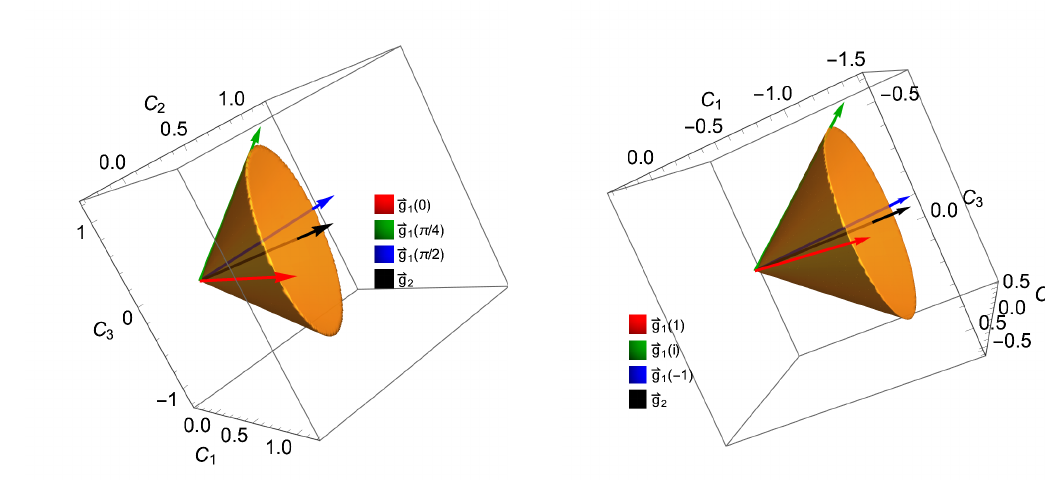
Figure 6. Left: positivity cone for hypercharge boson operators with parity violation. The cone is truncated by C + C 1 , to make the plot easier to read. Generators are also shown, with ~g 1 2 ≤ values at θ = 0 , π/ 4 , π/ 2 . Right: positivity cone for four-fermion operators with CP violation. The cone is truncated by C 1 , to make the plot easier to read. Generators are also shown, with ~g 1 ≥ − taking values at ρ = 1 , i, − 1